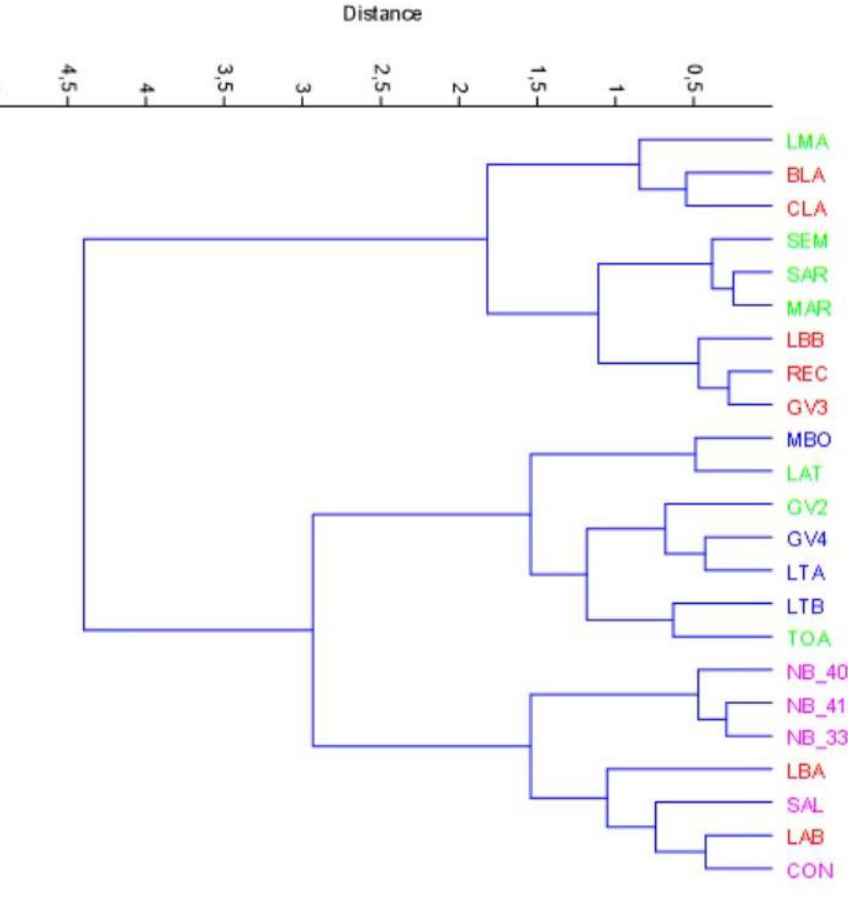
Figure 6. Cluster analysis (aggregative method, Ward’s algorithm, not constrained and Euclidean distance) of the whole data matrix. Legend: green, Itrana cv.; blue, Taggiasca cv.; lilac, Nocellara del Belice cv.; red, Bella di Cerignola cv.